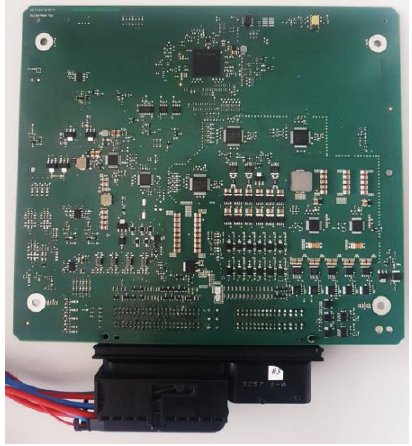
Figure 14. TCU evaluation board.